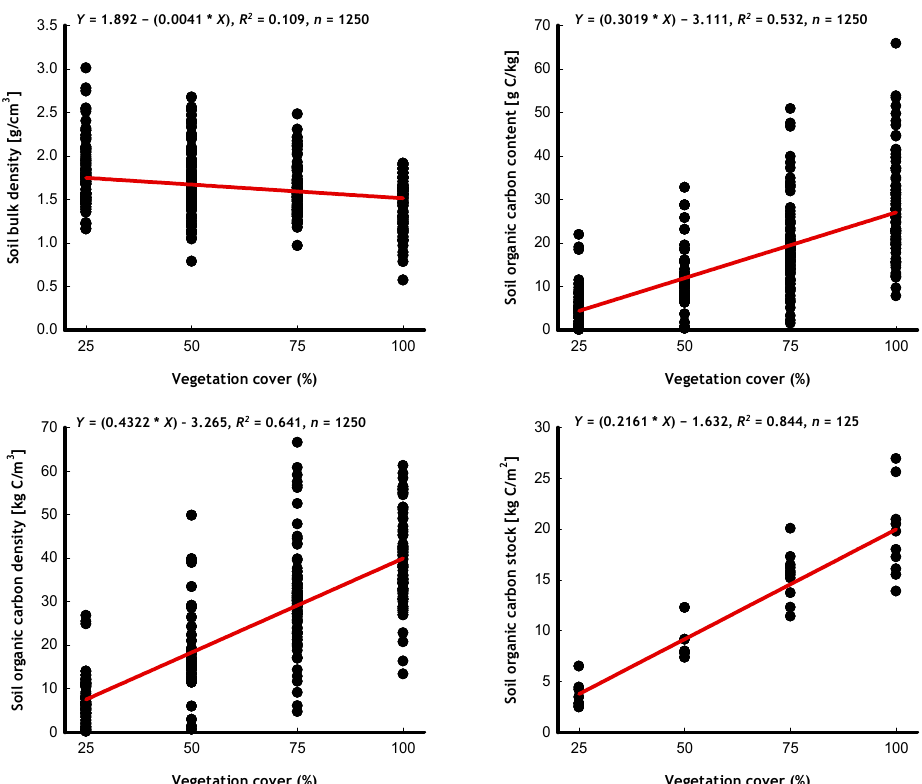
Figure 6. The relation between vegetation cover [%] and soil bulk density [g/cm 3 ], soil organic carbon content [g C/kg], soil organic carbon density [kg C/m 3 ], and soil organic carbon stock [kg C/m 2 ] of soil samples in ten sites represent ten sabkhas with different vegetation covers along the southern Red Sea coast of Saudi Arabia.